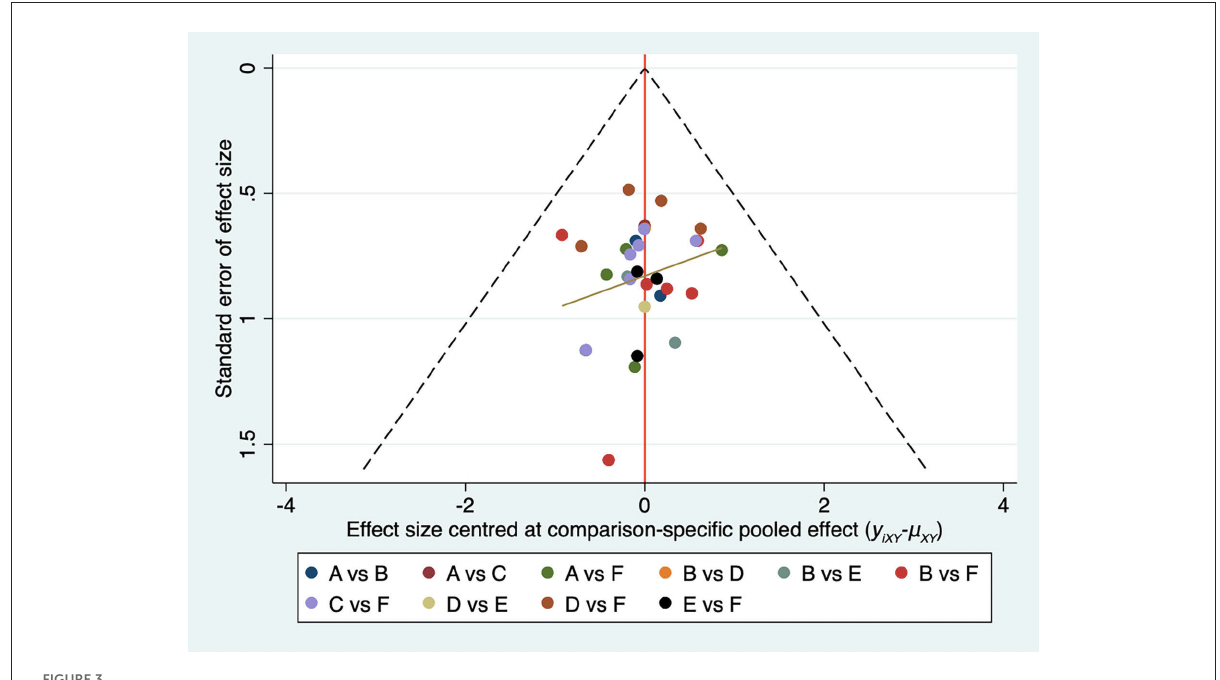
the somatotopic projections of mirror neuron brain